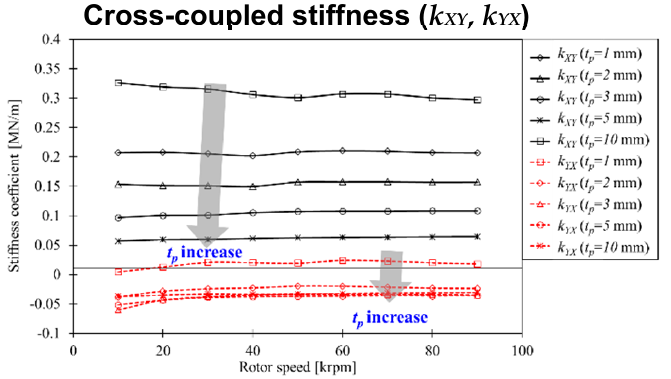
Figure 9. Predicted synchronous force coefficients versus the rotor speed depending on the polymer layer thickness: direct stiffness coefficients and direct damping coefficients.